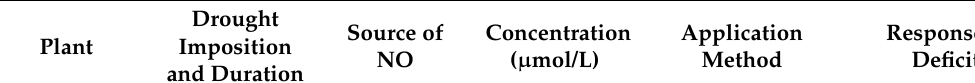
Table 1. Recent studies of nitric oxide on drought